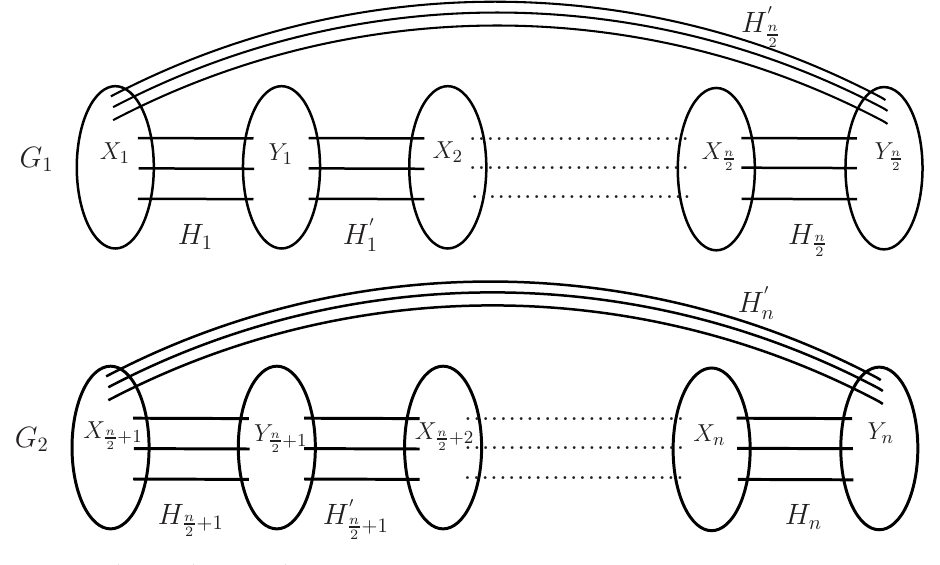
Figure 3. The graphs G 1 and G 2